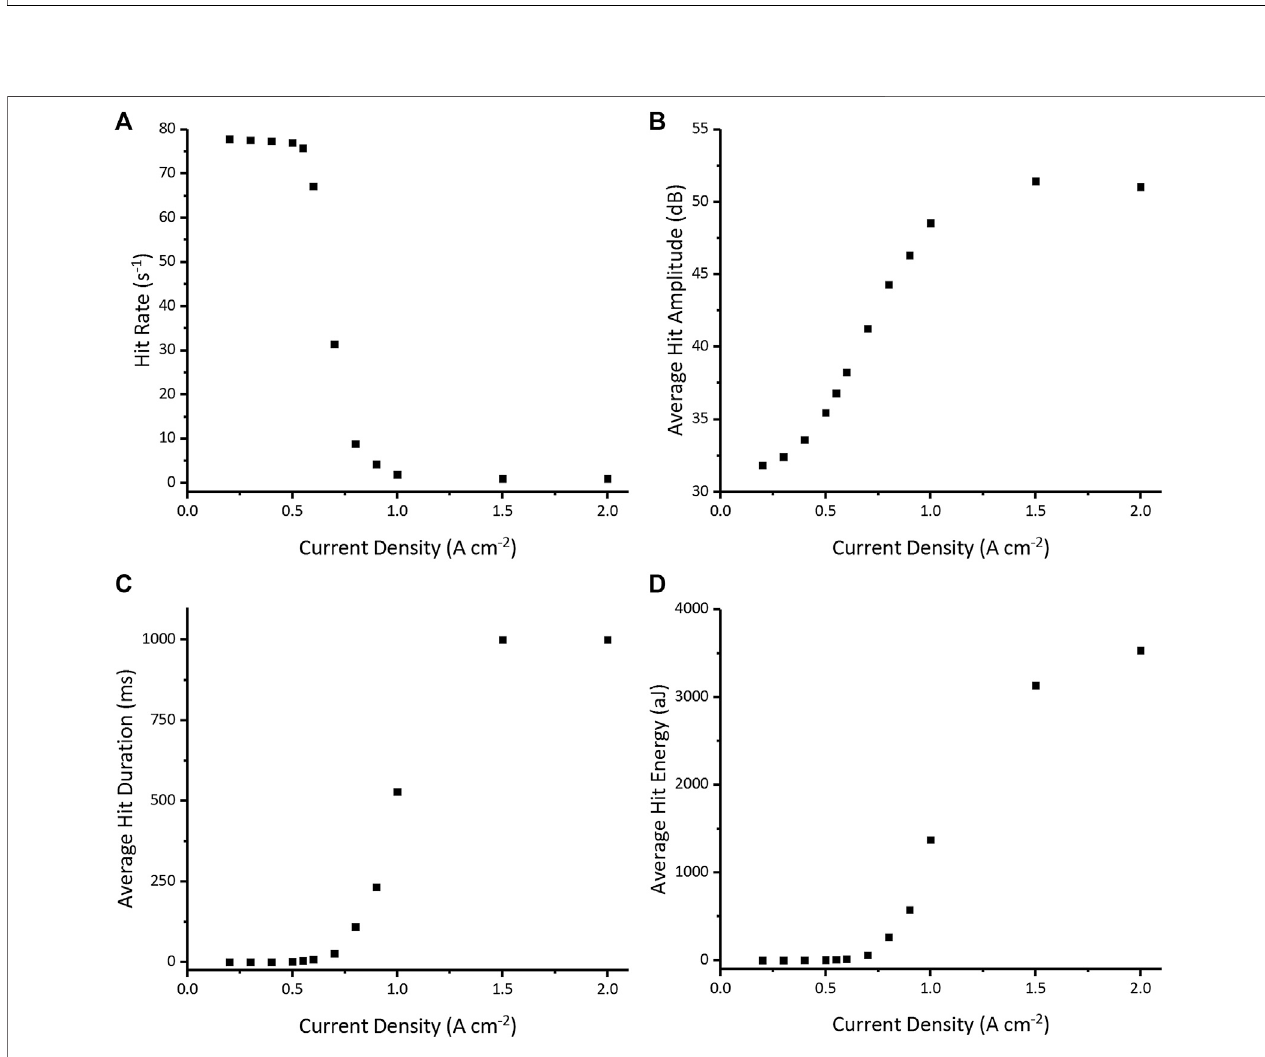
FIGURE 4 | Acoustic emission parameters as a function of current density for a water in fl ow rate of 10 ml min − 1 . Acoustic hit rate (A) , average hit amplitude (B) , average hit duration (C) , and average hit energy (D) are shown.